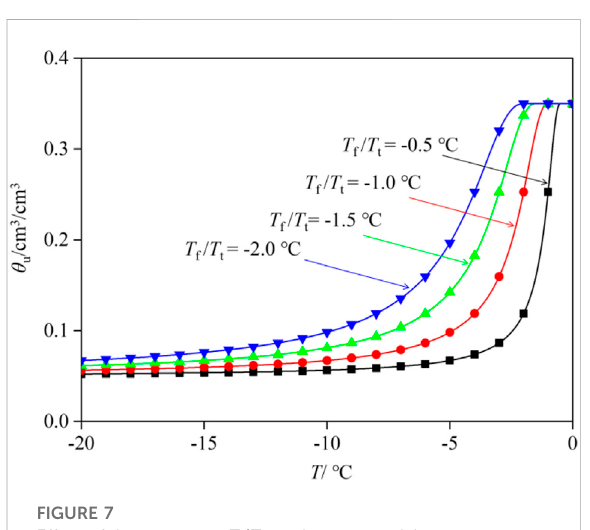
FIGURE 7 Effect of the parameter T f / T t on the new model.